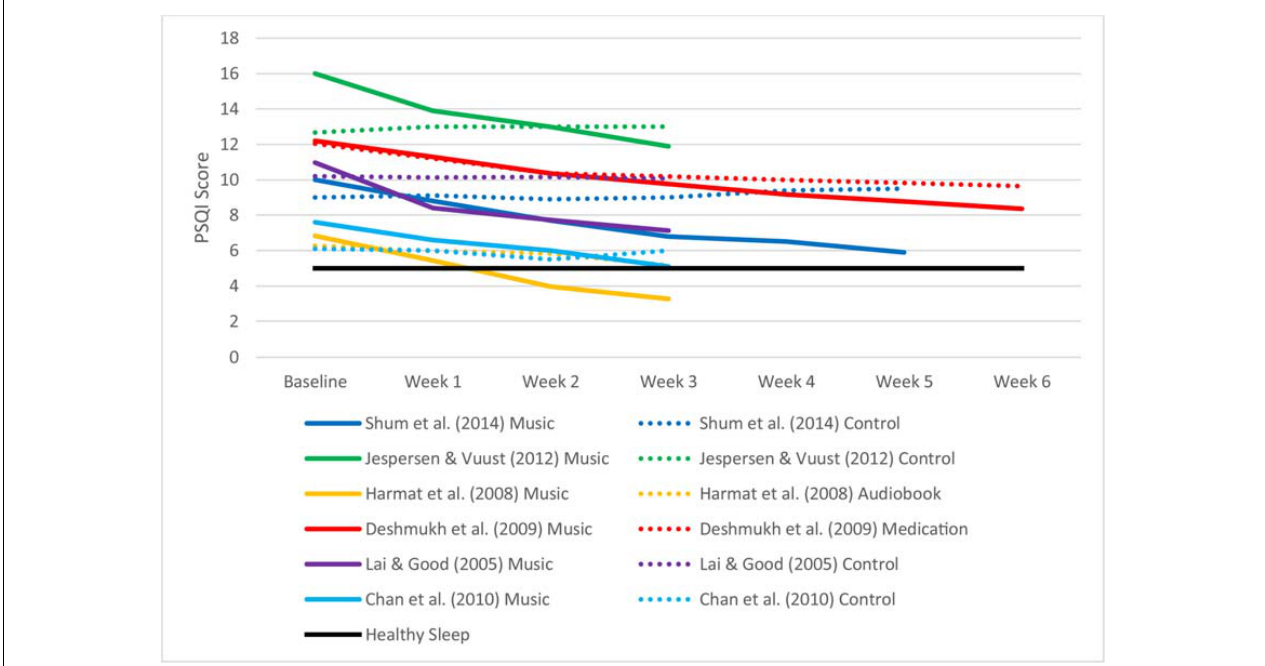
FIGURE 2 | Pittsburgh sleep quality index (PSQI) score for music interventions by exposure.